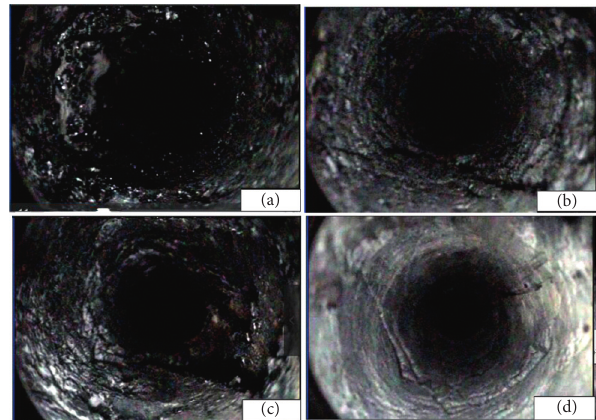
Figure 14: Still photographs from video footage obtained from a borehole drilled in the yield pillar. (a) 1.0m, (b) 3.0 m, (c) 2.0m, and (d) 4.0m.